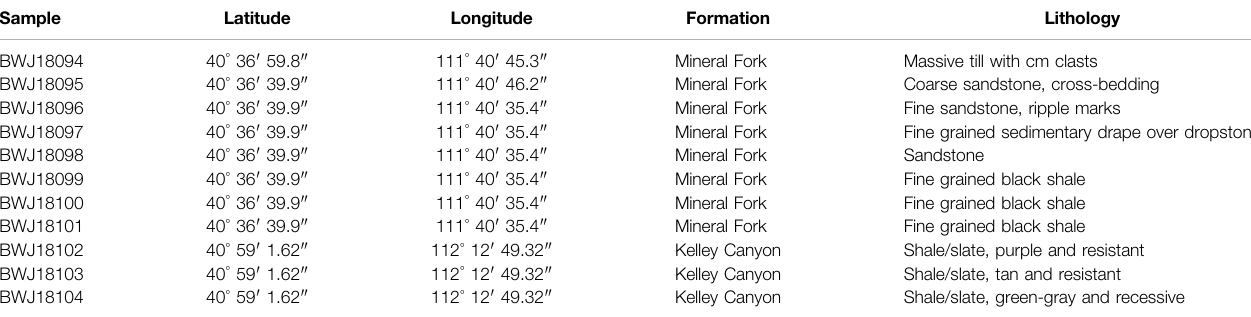
TABLE 1 | Sample location and geologic